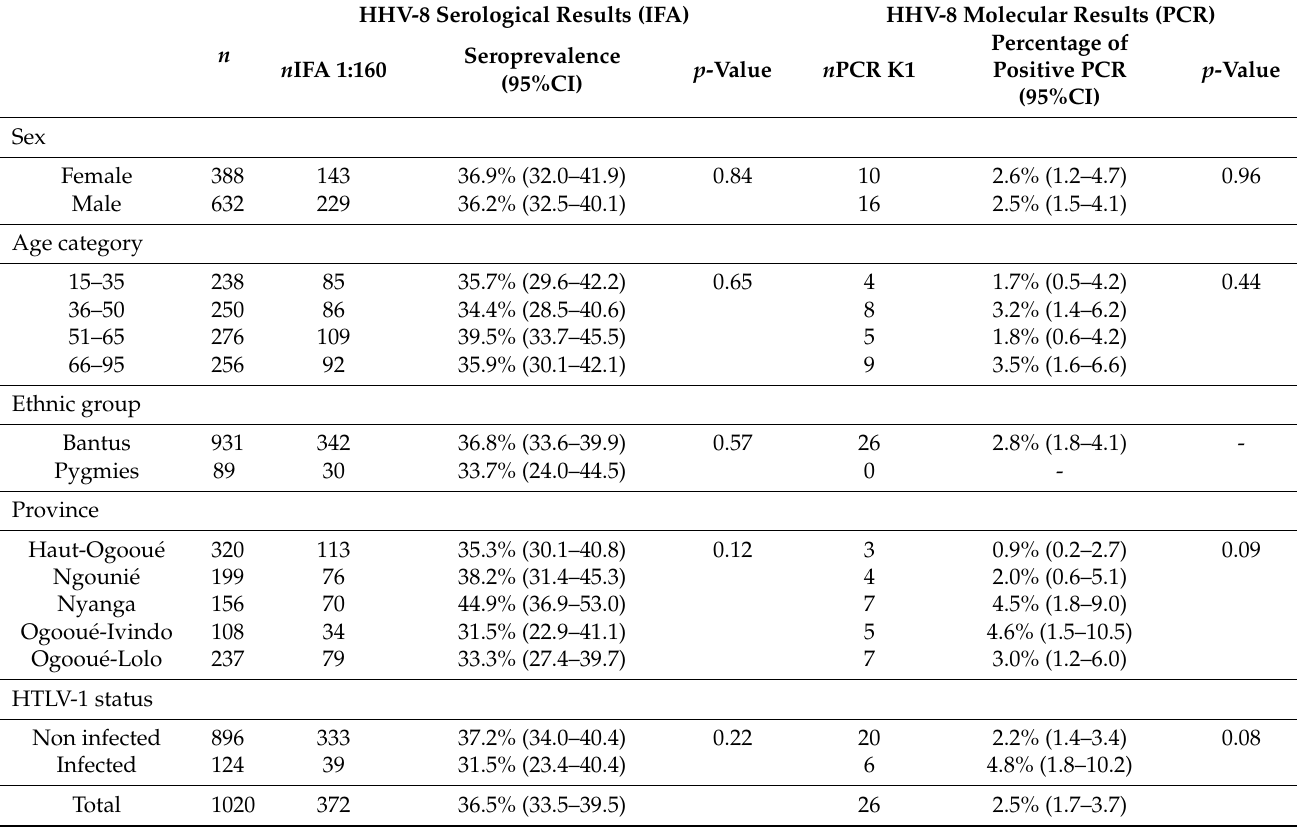
Table 1. Human herpesvirus-8 (HHV-8) serological (IFA) and molecular (PCR) results. HHV-8 Serological Results (IFA) HHV-8 Molecular Results n